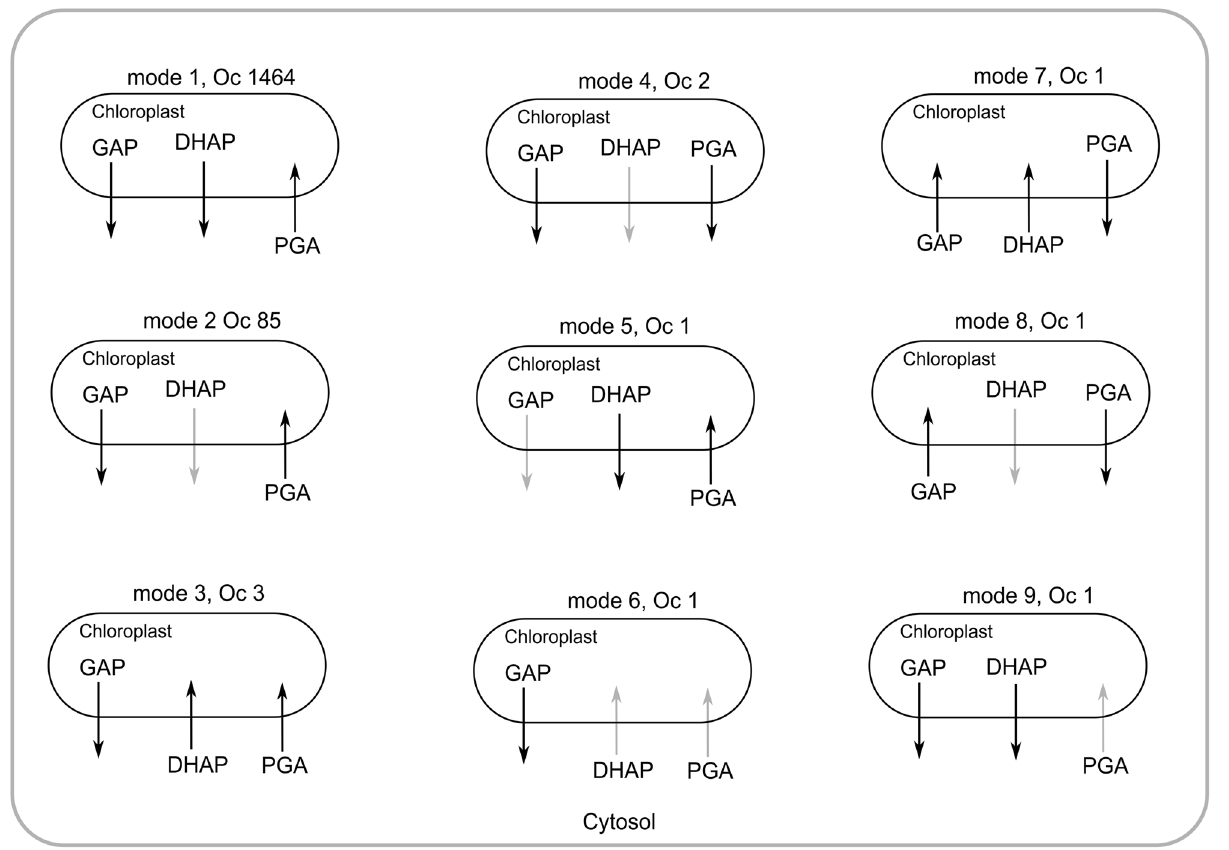
Fig 7. Different modes of the chloroplastic C 3 compound transporters (GAP, DHAP and PGA) observed due to deletions of reactions. ‘ Oc ’ referred to the number of occurrence of the particular mode in the total simulation. Faded arrow represents the inactive transporter. Mode 1 (WT mode) occurs most of the time, where chloroplastic GAP and DHAP are transported to the cytosol and cytosolic PGA is transported to the chloroplast.